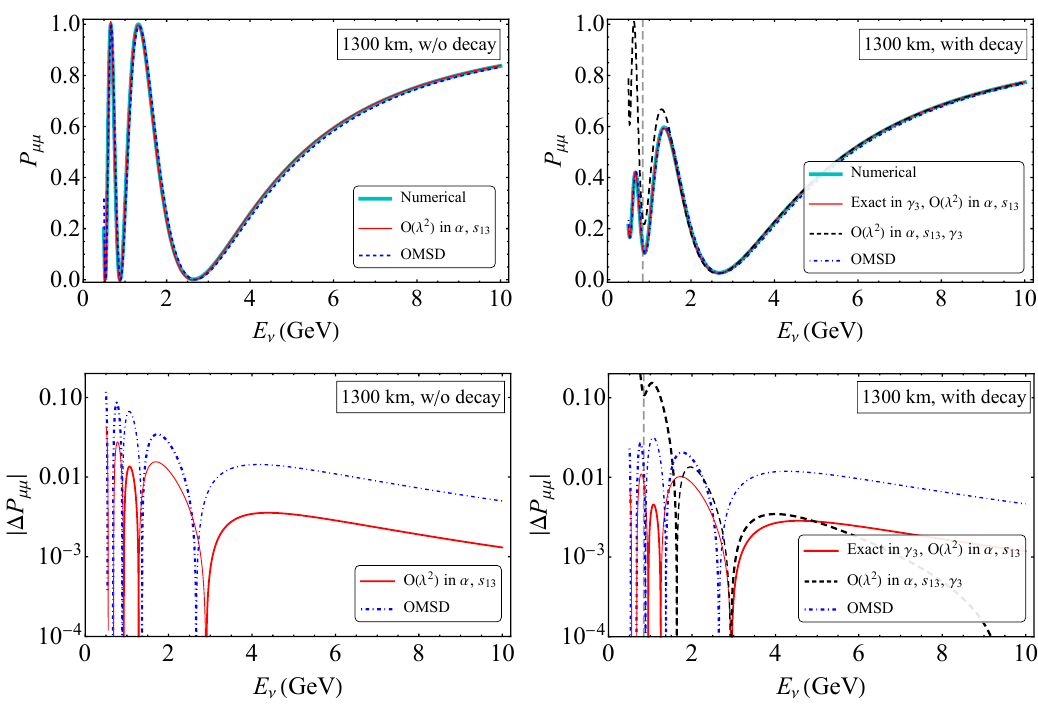
Figure 1 . The top panels show probabilities P µµ in the scenarios without (left) and with (right) decay, for L = 1300 km and γ = 0 . 1 . The bottom panels show the absolute error | ∆ P 3 analytic expressions shown. The thick (thin) curves indicate positive (negative) signs of ∆ P dashed vertical line at E 0 . 8 GeV corresponds to λ ∆ = 1 , to the left of which the expansion in ν ' γ 3 is not expected to be